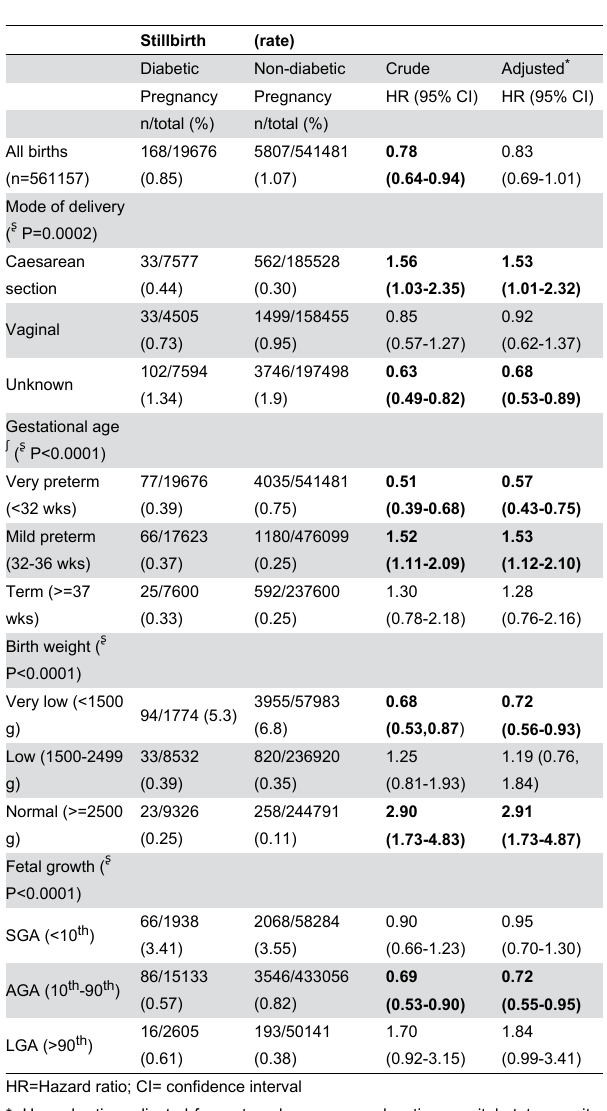
Table 3. Stillbirth in diabetic versus non-diabetic twin pregnancies, U.S. matched multiple birth data 1995-2000